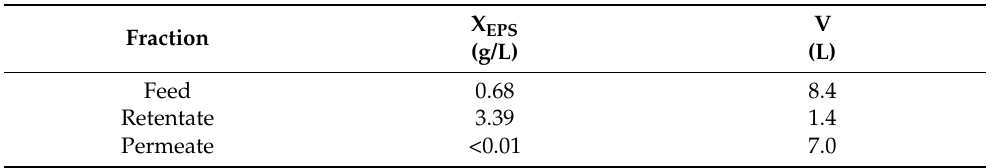
Table 2. The dry weight of extracellular polysaccharides (X EPS ) and volumes (V) of feed, retentate and permeate fractions in the ultrafiltration